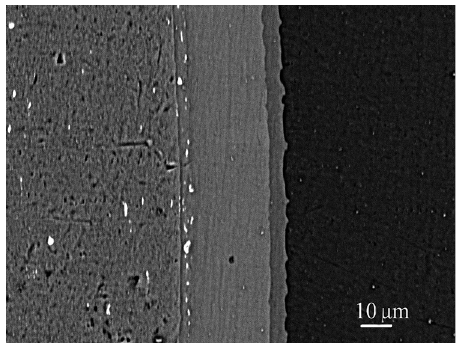
Figure 7: SEM micrographs of the Mg/Al